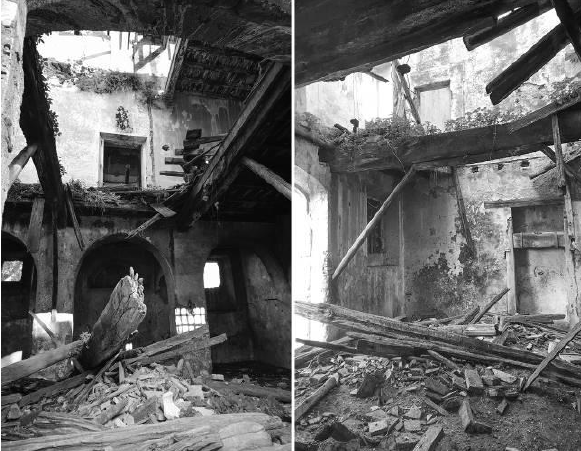
Figure 7. Internal collapses denounce the state of abandonment and the impossibility of detecting some Casale’s